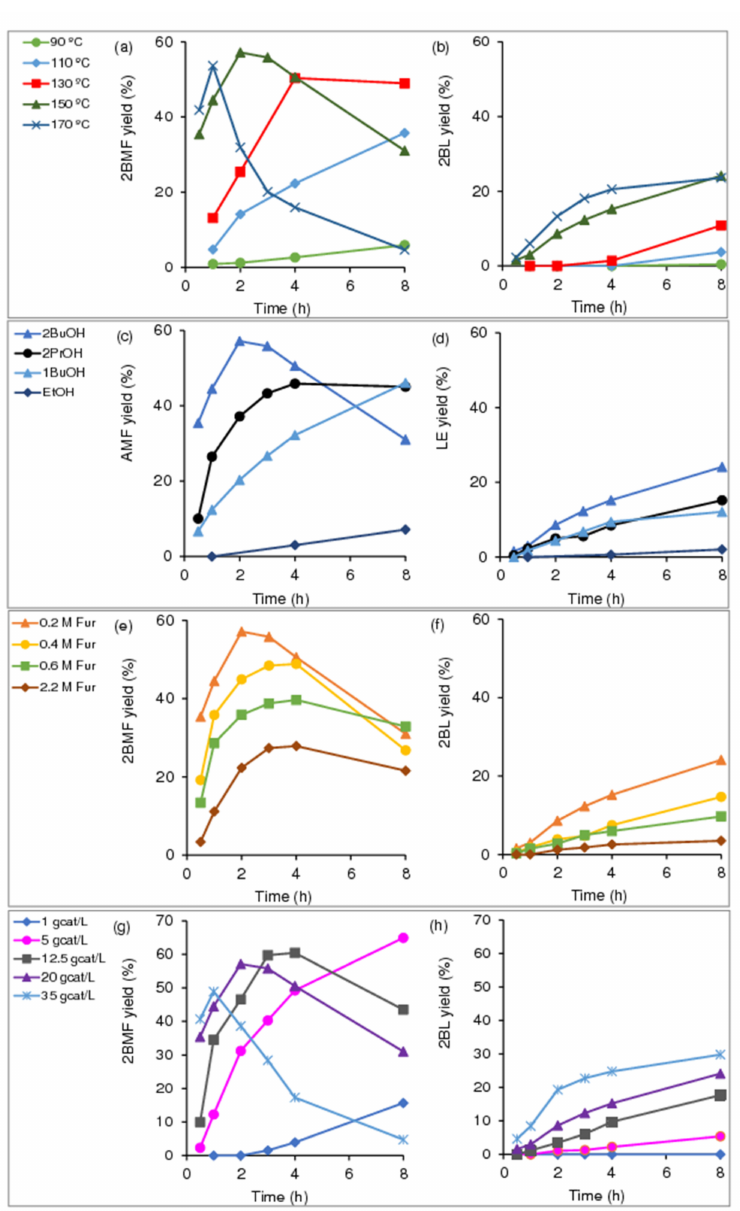
Figure 5. Influence of the reaction temperature ( a , b ), type of solvent ( c , d ), initial Fur concentration ( e , f ), and catalyst dosage ( g , h ) on the yields of AMFs ( a , c , e , g ) and LEs ( b , d , f , h ) for the reaction of Fur, in the presence of Hf-TUD-1(50). Reaction conditions: ( a , b ) 0.2 M Fur in 2BuOH, 20 g cat L − 1 ; ( c , d ) 0.2 M Fur, 20 g cat L − 1 , 150 ◦ C; ( e , f ) 2BuOH, 20 g cat L − 1 , 150 ◦ C; ( g , h ) 0.2 M Fur in 2BuOH, 150 ◦ C. Results up to 72 h and for FA, AnLs, and LA are given in the Supplementary